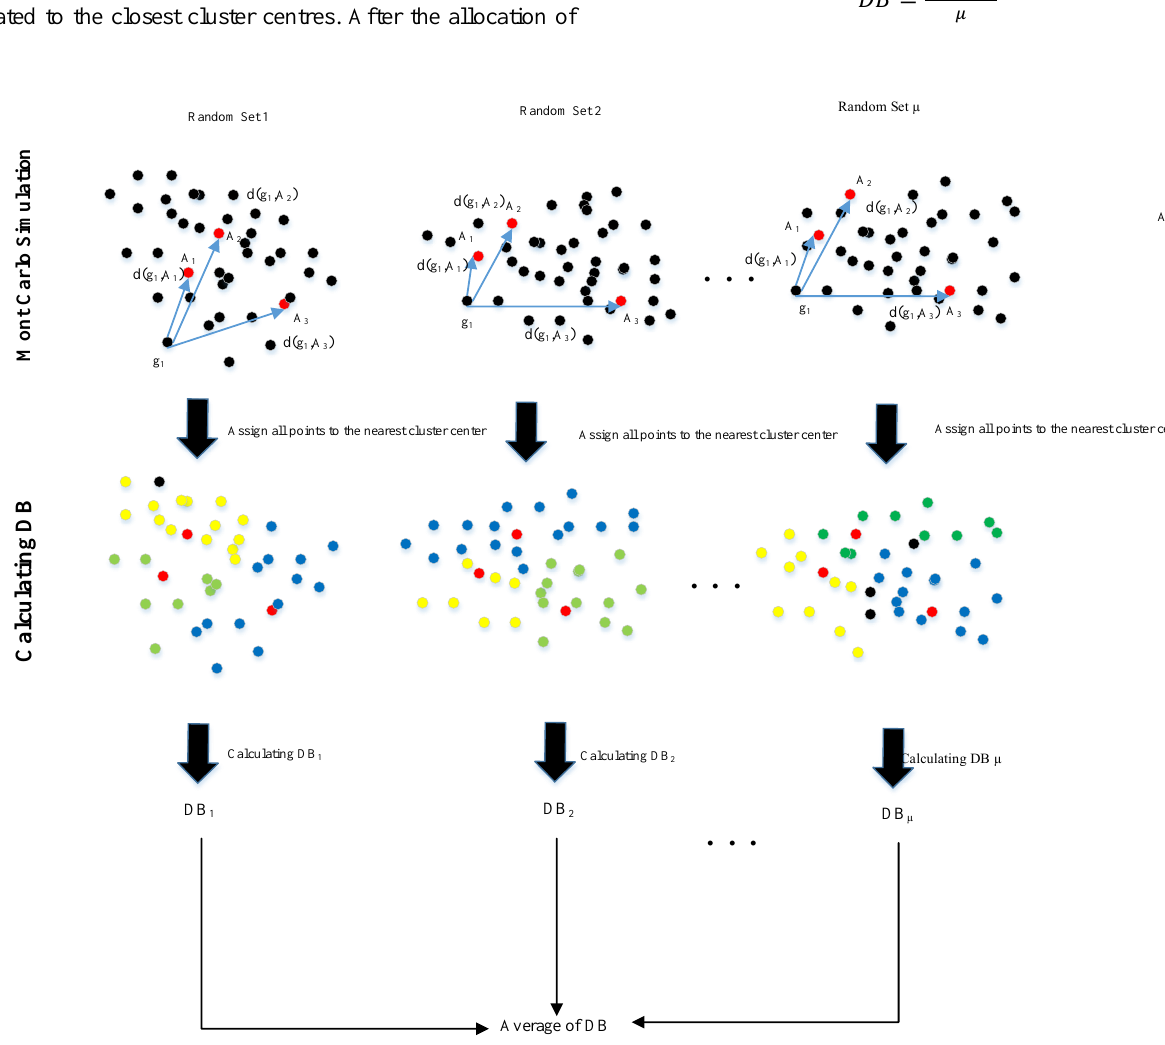
Fig. 4. Calculation mechanism of fitness function with Monte Carlo